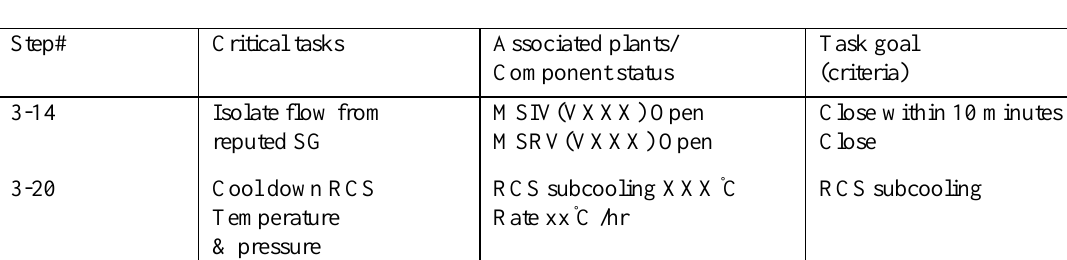
Figure 7. Critical task list